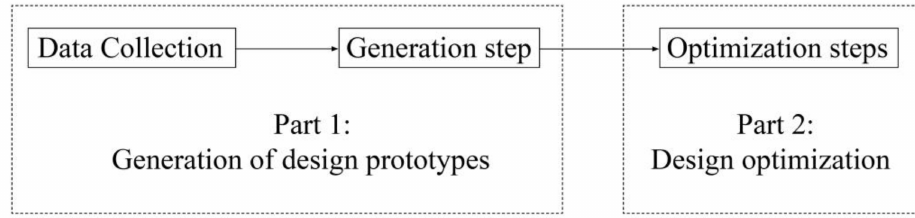
Figure 4. Basic steps of design generation and optimization.